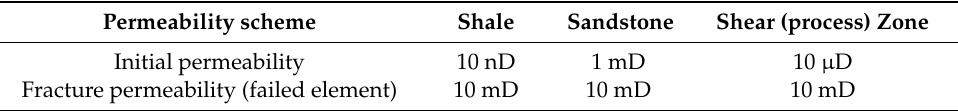
Table 2. Assigned permeability values in the simulation domain.